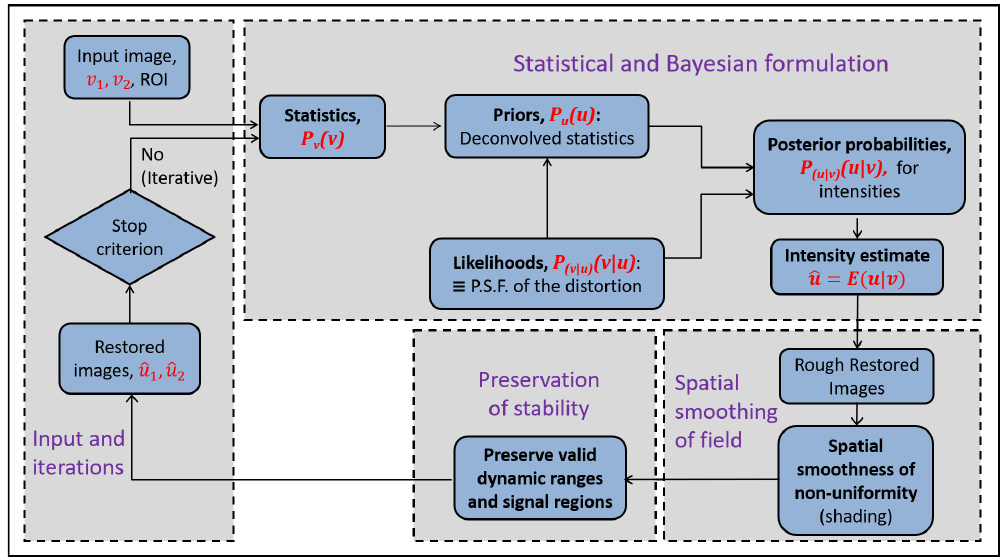
Figure 3. Overview of the series of steps in the implementation of the Bayesian formulation for image restoration. The restoration is joint for two images and